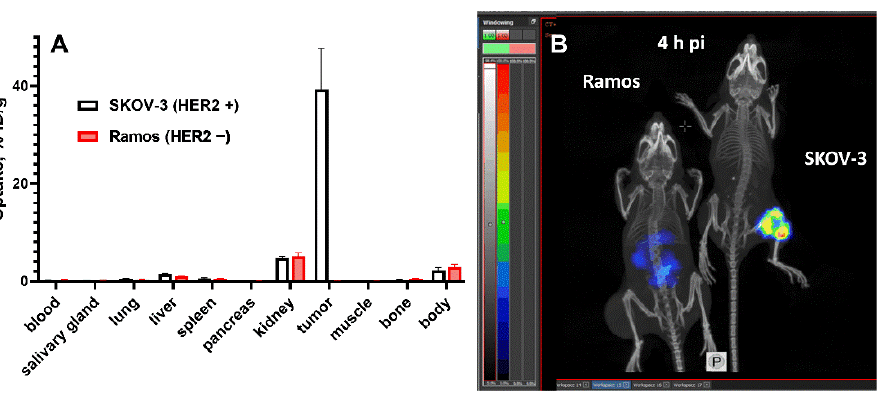
Figure 7. The HER2-specificity of 188 Re-ZHER2:41071 accumulation in tumor xenografts was evalu- ated by comparison of the uptake in HER2-positive SKOV-3 and HER2-negative Ramos xenografts in BALB/C nu/nu mice 4 h after injection. ( A ) Biodistribution. Results of ex vivo measurements are presented as % ID/g ± SD ( n = 4). ( B ) Imaging of 188 Re-ZHER2:41071 in BALB/C nu/nu mice bearing SKOV-3 and Ramos xenografts 4 h after injection. The scale is linear showing arbitrary units nor- malized to a maximum count rate.